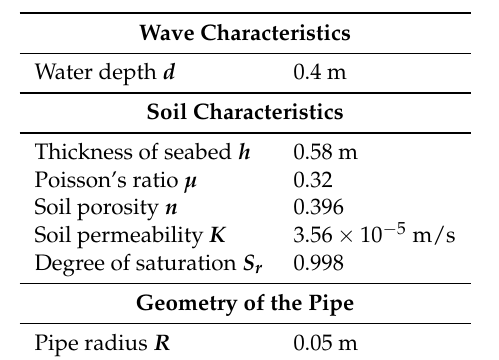
Table 2. Input data for the comparison with experimental data [40].